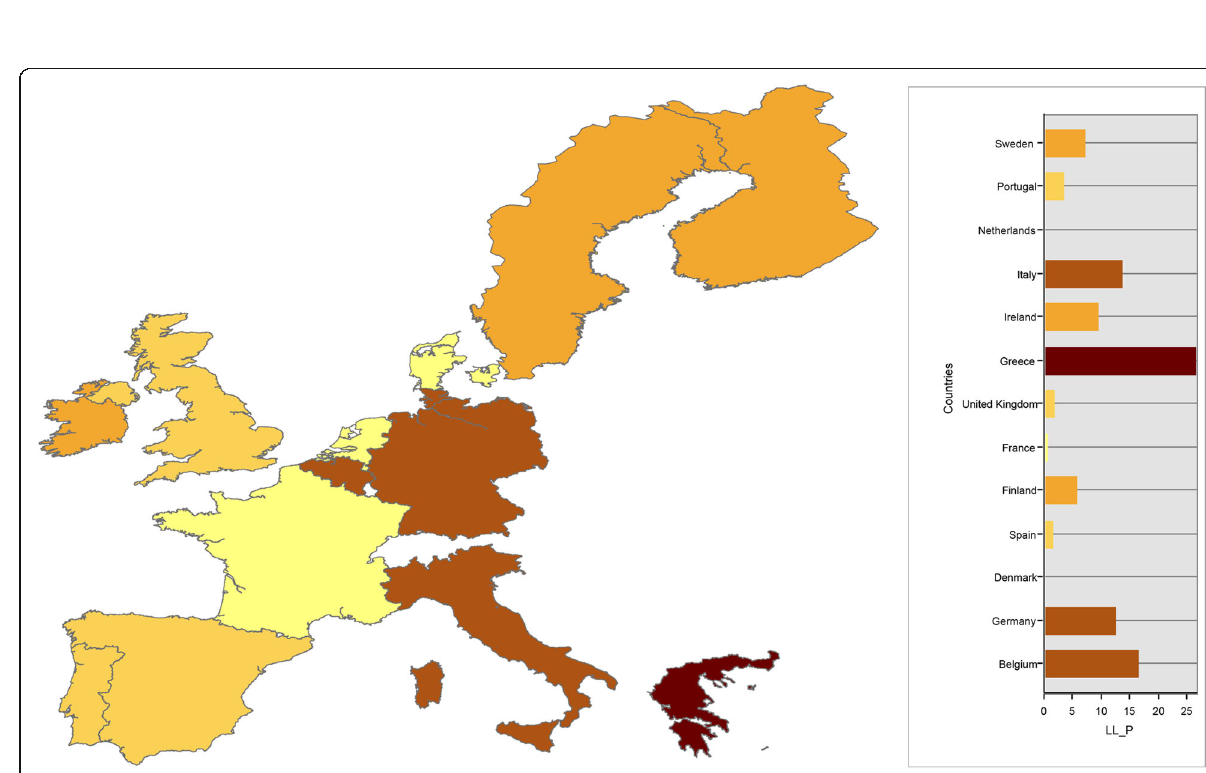
Fig. 12 Detainable remarks percentage for the Load Lines Protocol for EU15